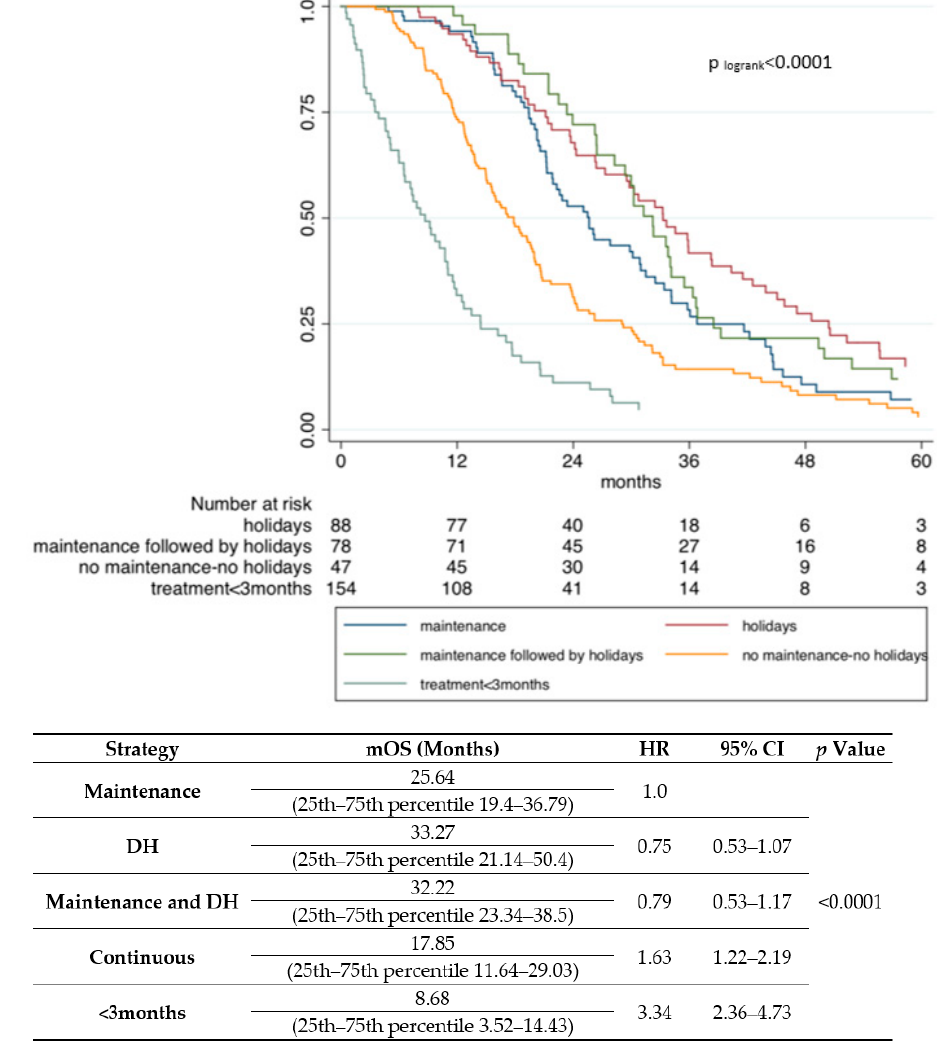
Figure 2. Kaplan–Meier survival curves according to strategy in patients with score <3.